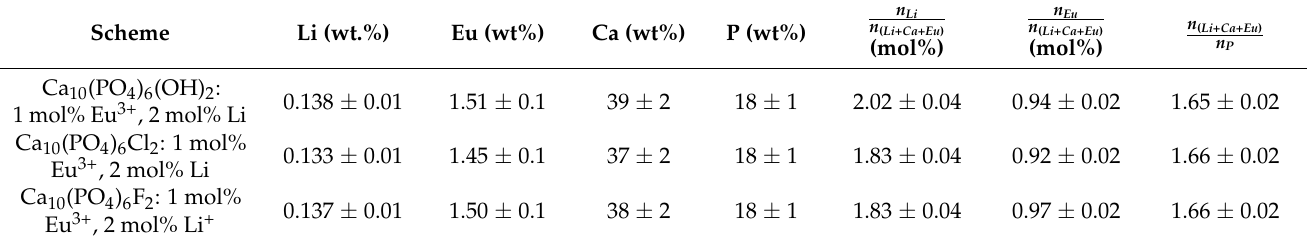
Table 5. The element content in the obtained hydroxyapatite measured by ICP-OES technique.